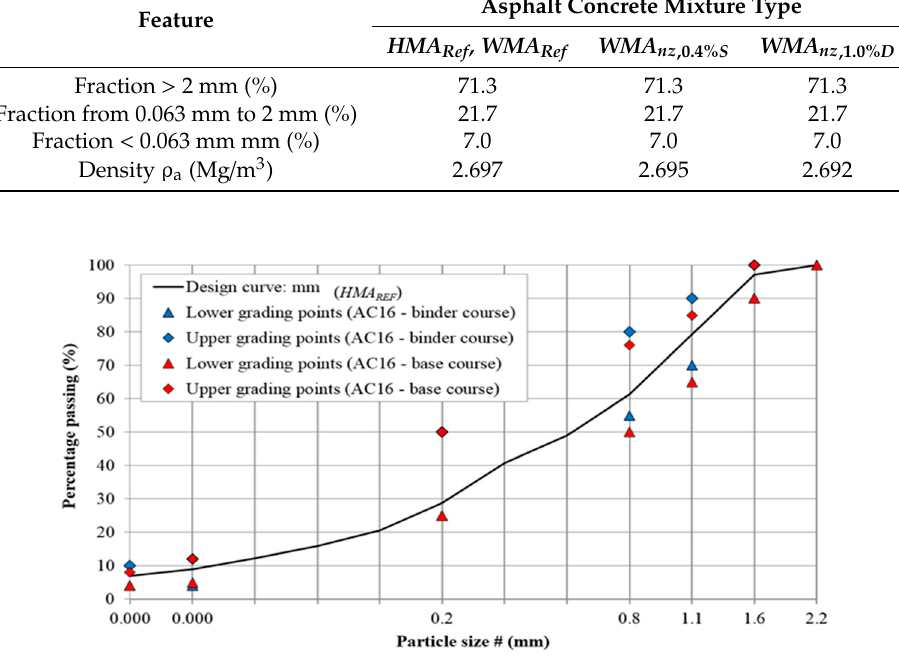
Figure 6. Grading curve of the AC 16 mineral mix with boundary points in accordance to WT-2 [44]. The aforementioned results indicate that the presence of zeolite in the mineral mixes did not cause changes in their granulometry in comparison to reference mixes and only the mineral mixes’ density ( ρ a ) has slightly